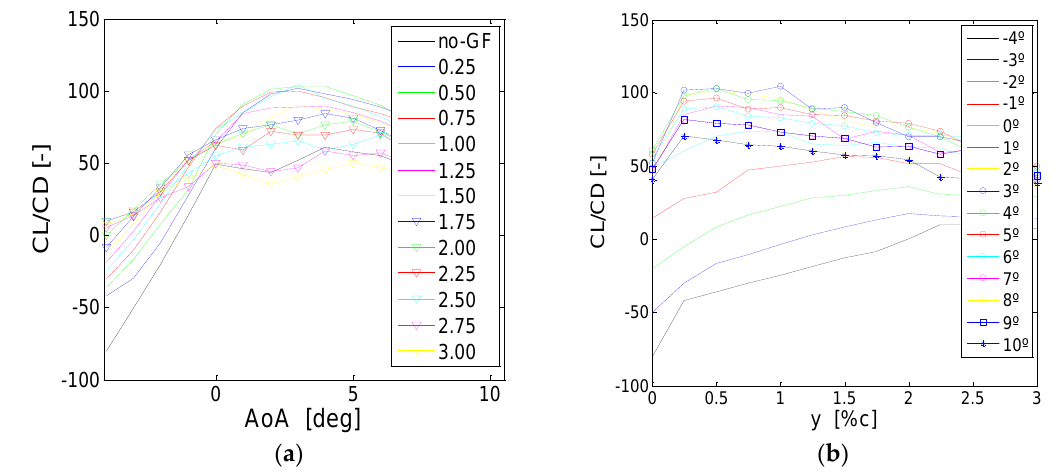
Figure 6. Lift-to-drag ratio C L /C D evolution for all GF cases: ( a ) for every angle of attack α and; ( b ) versus GF sizes.